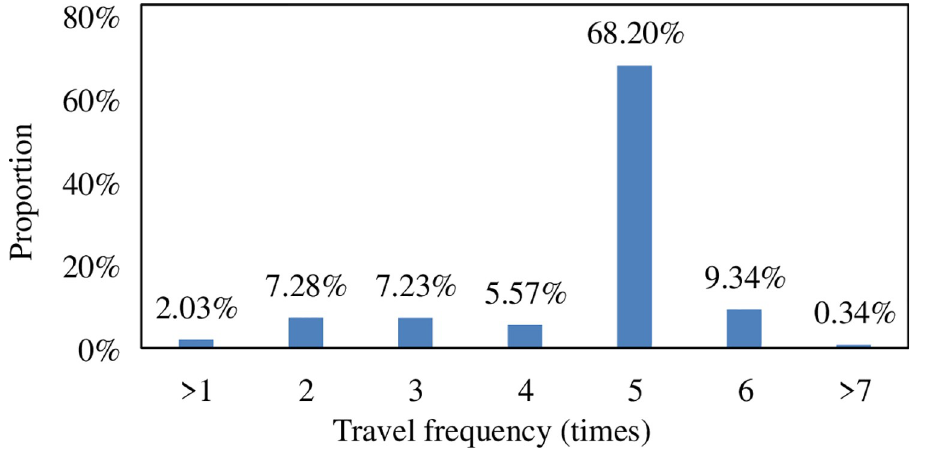
Fig 6. Population travel frequency distribution.in the beijing